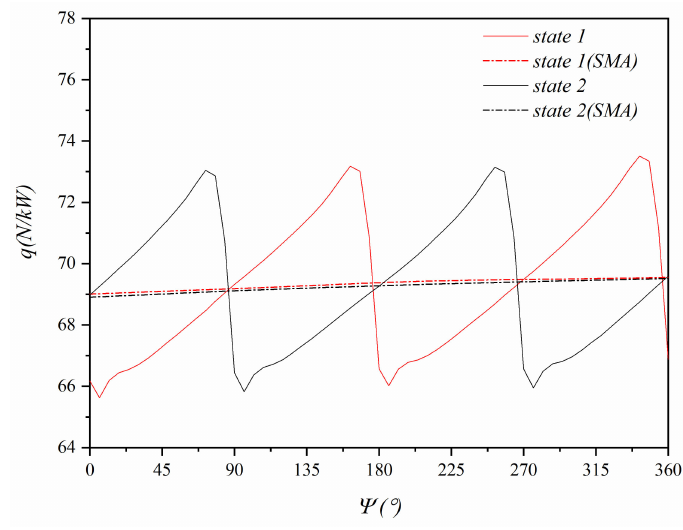
Figure 15. The isolated rotor q in hover.